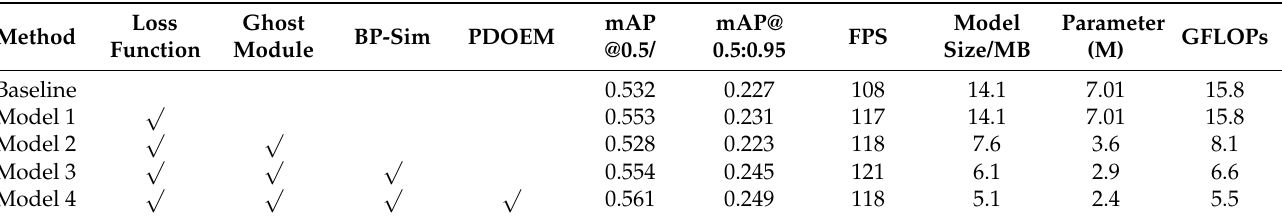
Table 4. The results of ablation experiments performed by the improved module. Batchsize = 32, image size = 640.